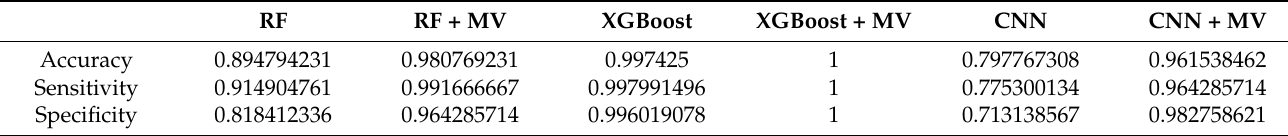
Figure 9. Classification performance, maximum tuberization phenological stage using four classes. Table 4. Comparison of classification performance of RF, XGBoost, and CNN alone and using MV for the maximum tuberization phenological stage using four classes.